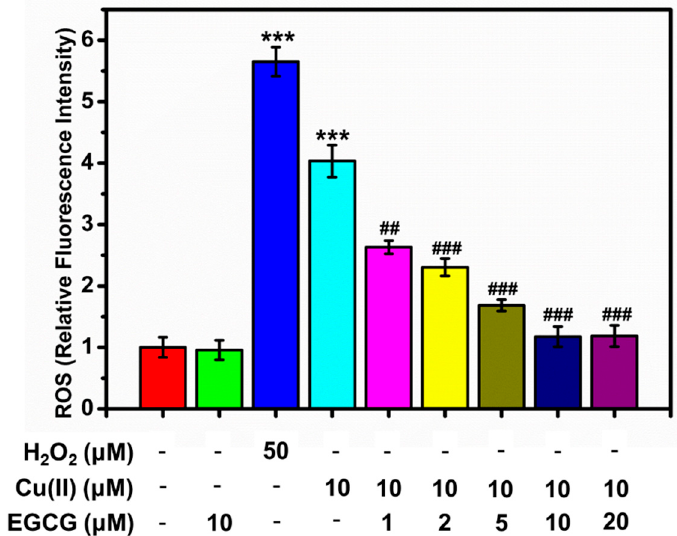
Figure 9. ROS in the α -Syn transduced PC12cells treated by H 2 O 2 for 15 min, Cu(II), and EGCG for 24 h. Error bars = SD, n = 3; ***: p < 0.001 vs. control group; ##: p < 0.01, ###: p < 0.001 vs. [Cu(II)] = 10 μ M.